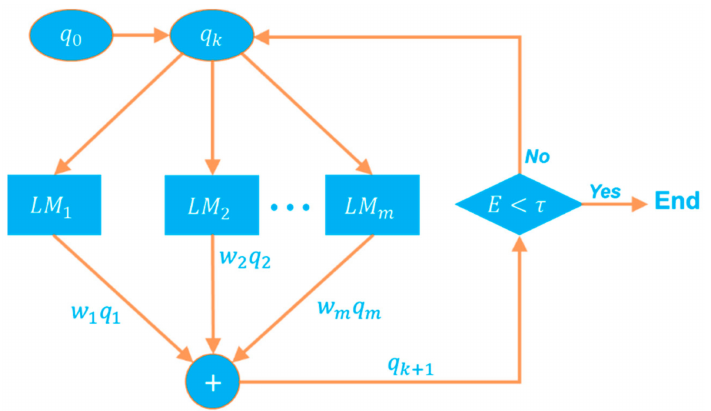
Figure 2. The principle of the multiple image-based LM algorithm, where q 0 denotes the initial guess of the parameter to be solved, LM m denotes the m th image processed by LM algorithm, and τ denotes the error tolerance.